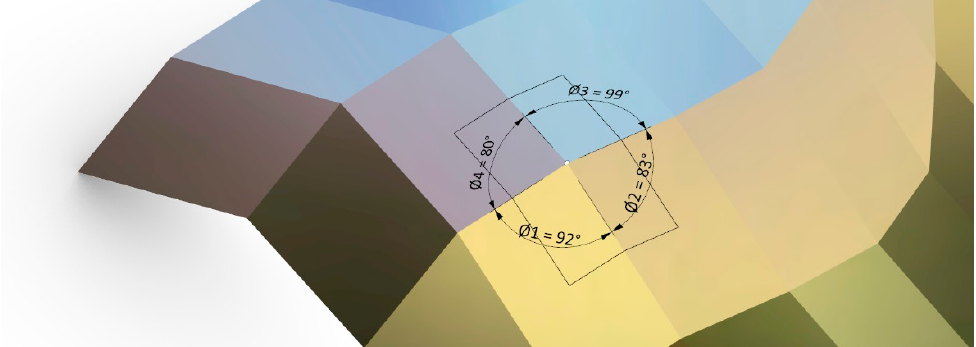
Figure 10. The total angle around a vertex is not a full angle on synclastic surfaces, whereas it is more than a full angle on anticlastic surfaces.